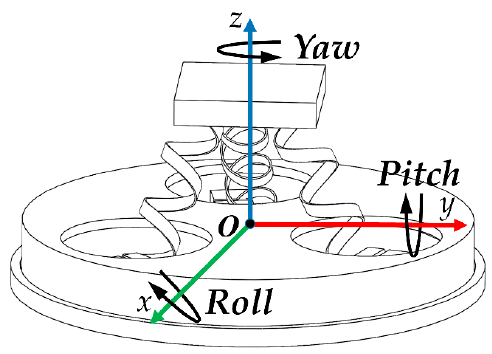
Figure 18. 3D model of the 3-DOF micro-parallel platform.